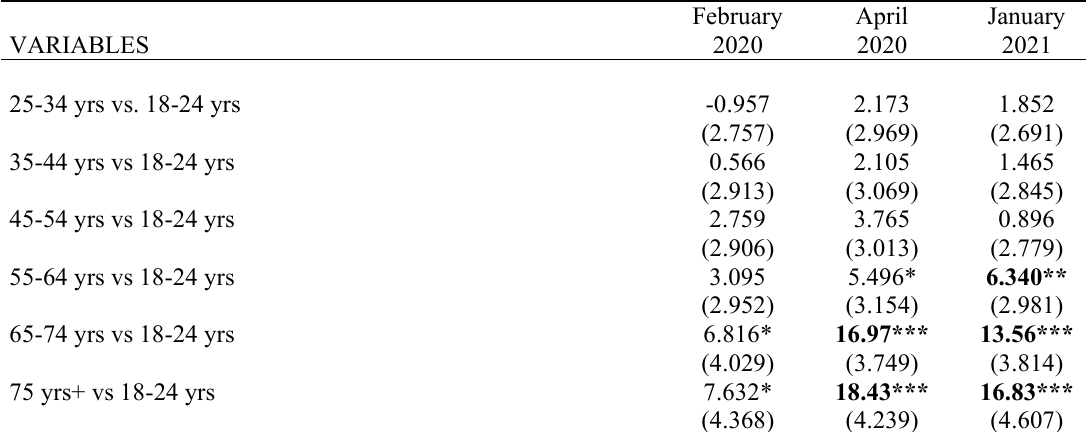
Table 3: Regressions of HRQoL on VAS scale